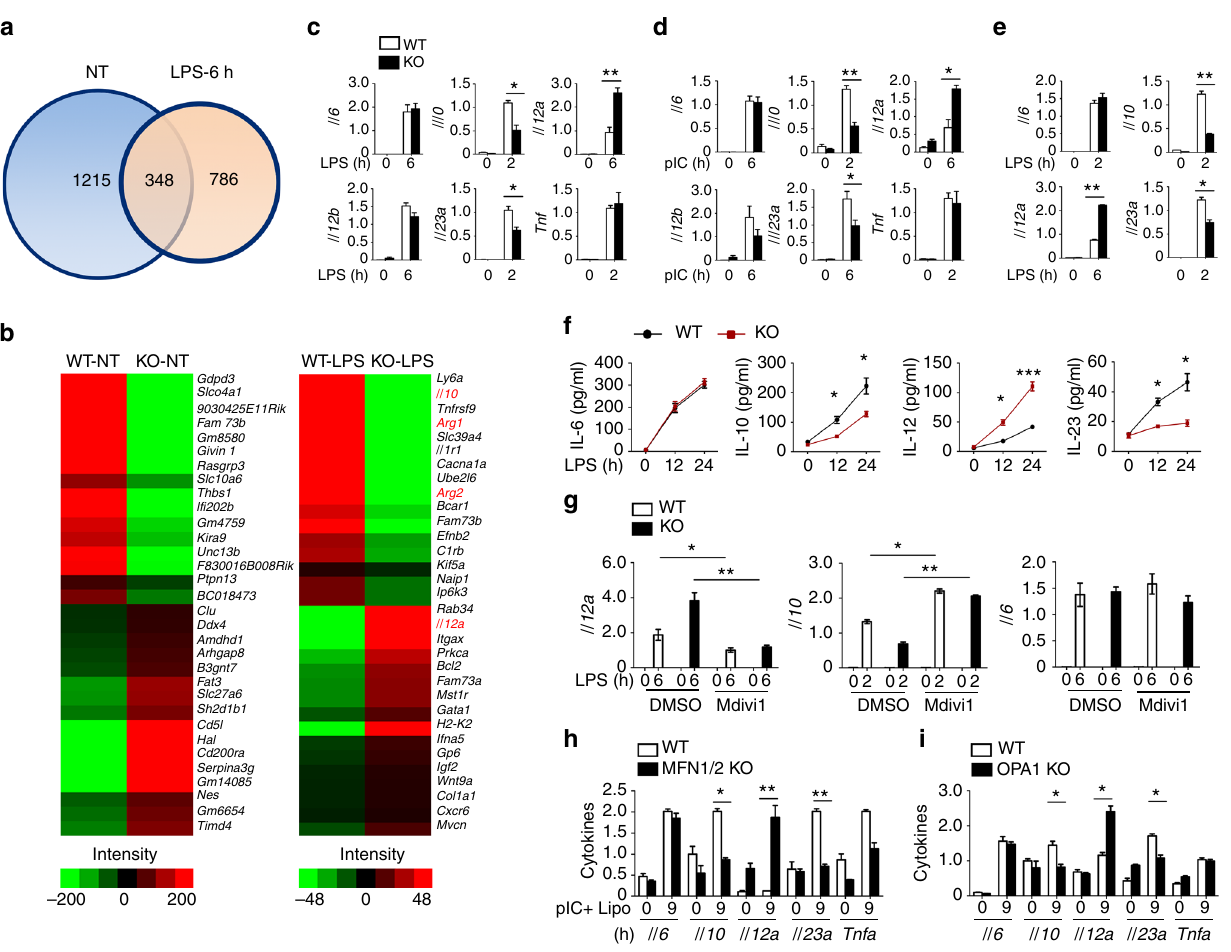
Fig. 4 Mitochondrial fi ssion is required for induction of Il12a . Transcriptome analyses of FAM73b-regulated genes in primary BMDMs from sex-matched WT and FAM73b KO mice (8 weeks old). a Venn diagram illustrating the overlap of differentially expressed genes between WT and FAM73b KO BMDMs under non-treatment or LPS-stimulated conditions for 6 h. b Heat map showing basal (left panel) and LPS-response (right panel) differentially expressed genes in WT and FAM73b KO BMDMs. qRT-PCR analysis of the indicated genes using WT or FAM73b KO BMDMs stimulated with LPS ( c ) or poly(I:C) ( d ). e ELISAs of the indicated cytokines in the supernatants of WT or FAM73b KO BMDMs stimulated with LPS for 12 and 24 h. f The indicated gene levels in WT and FAM73b KO BMDCs were measured with qRT-PCR. g qRT-PCR analysis of LPS-induced genes changes after treatment with Mdivi-1 for 12 h. h , i WT and MFN1/2- ( h ) or OPA1-de fi cient ( i ) MEFs were stimulated with Lipofectamine-delivered poly I:C for 9 h. The indicated genes were detected by qRT-PCR. All the data are presented as fold-induction relative to the Actb mRNA level. The data are presented as the mean ± SEM values and representative of at least three independent experiments. Statistical analyses represent variations in experimental replicates. Two-tailed unpaired t -tests were performed. * P < 0.05; ** P < 0.01; *** P <